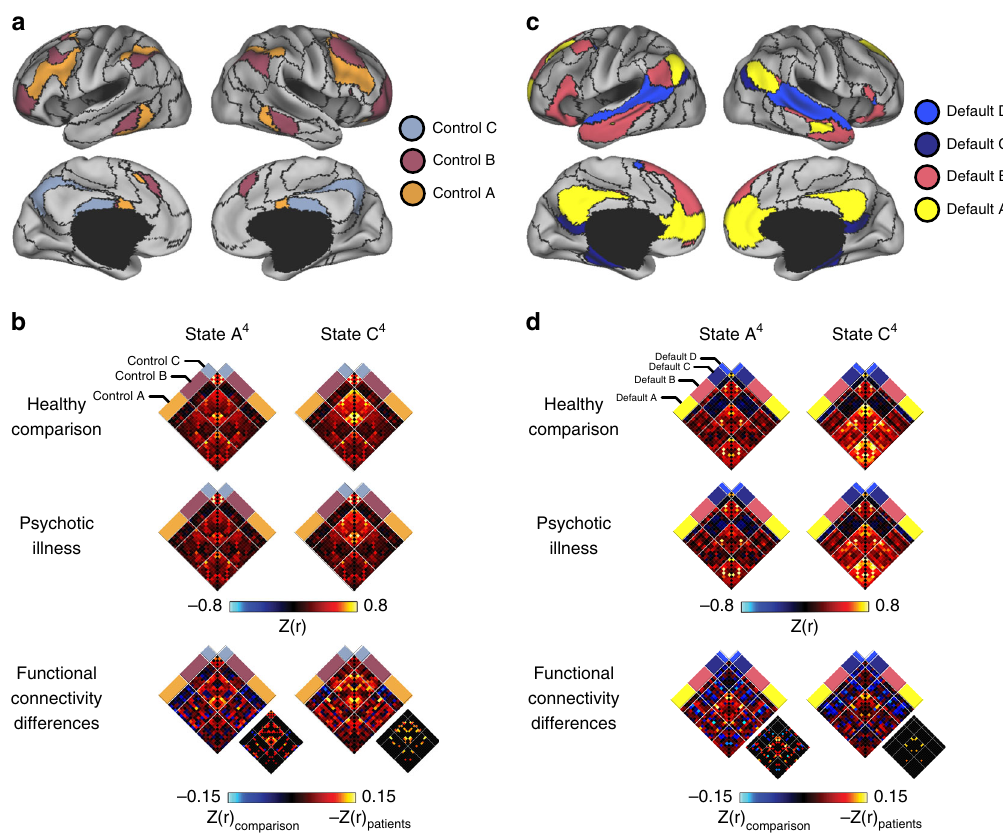
Fig. 8 Psychosis is associated with reduced network connectivity in states A 4 and C 4 . a The colored aspects of the cortex re fl ect regions estimated to be within the A, B, and C aspects of the frontoparietal control network 39 . b Functional connectivity matrices for the 50 left and right hemisphere regions of the frontoparietal control network shown for the healthy comparison and patient groups in states A 4 and C 4 . Functional connectivity difference matrices were obtained by an analysis of variance of z-transformed Pearson correlation values after linear regression of the effects of age, sex, handedness, and scanner bay. Group differences signi fi cant at false-discovery rate q ≤ 0.05 are shown in each panel to the lower right of the unthresholded matrix. c The colored aspects of the cortex re fl ect regions estimated to be within the A, B, C, and D aspects of the default network. d Corresponding connectivity matrices are shown in 52 left and right hemisphere regions of the default regions for states A 4 and C 4 . Reduced default network connectivity in psychosis is